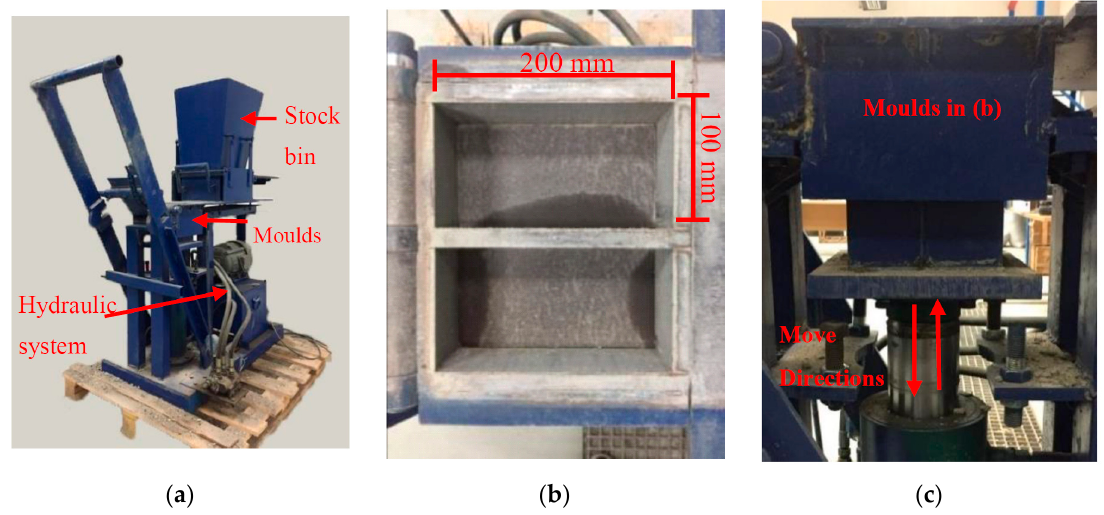
Figure 3. Full view and detailed images of the brick making machine. ( a ) hydraulic brick making machine; ( b ) two moulds for deforming the concrete paving blocks; and ( c ) baseboard for load application.